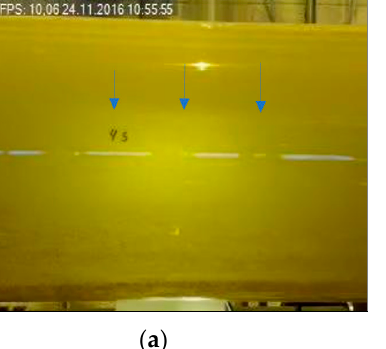
Figure 18. Displacement in washout section for horizontal flow in concentric annulus ( a ) and for eccentric annulus ( b ). Arrows indicate position of interface between displaced fluid and displacing fluid, where displacing fluid is below arrows ( a ) or below and to the right of arrows ( b ).